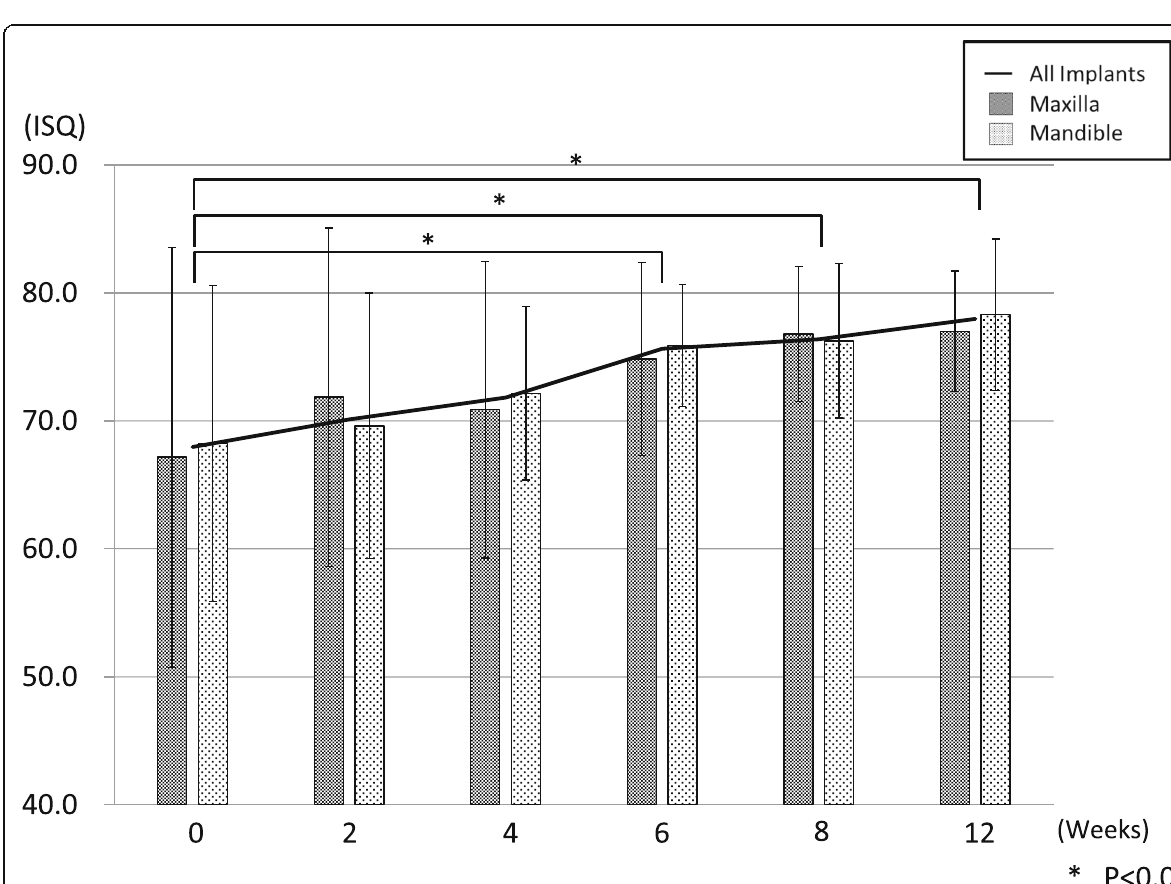
Fig. 3 The evaluation of the average ISQ. Time-lapse migration of average ISQ. Average ISQ of all specimens increased in a time-dependent manner (results indicated by a line). A significant difference was observed by 6 weeks after